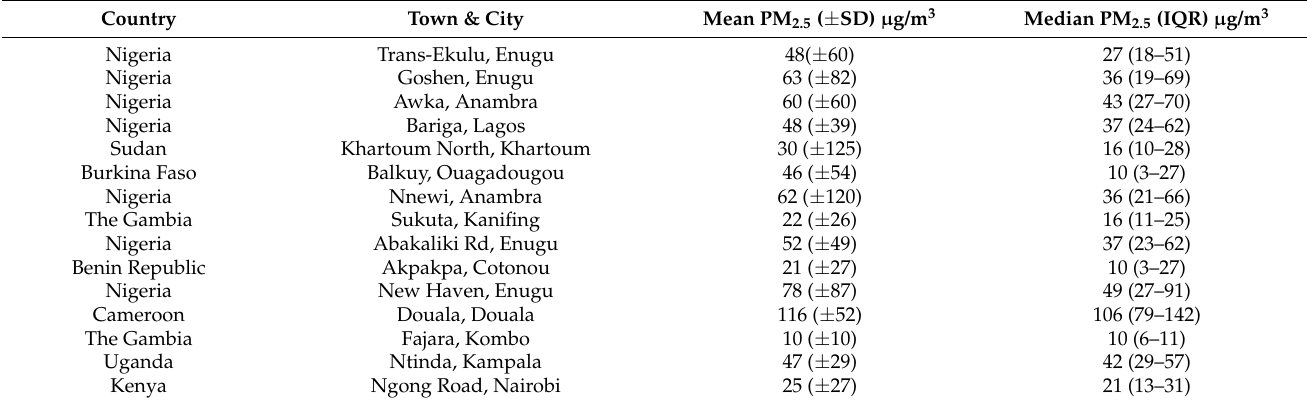
Table 2. Mean and median PM 2.5 for each site between February 2020 and January 2021.